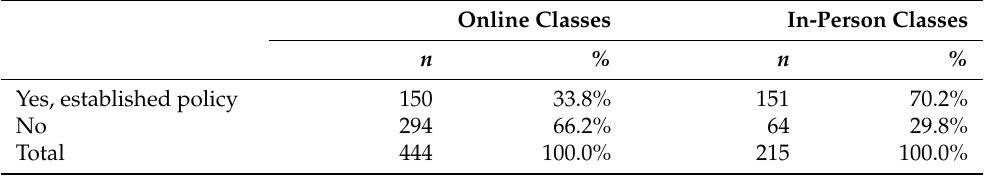
Table 8. Have your professors introduced a course policy regarding the use of digital devices during class?